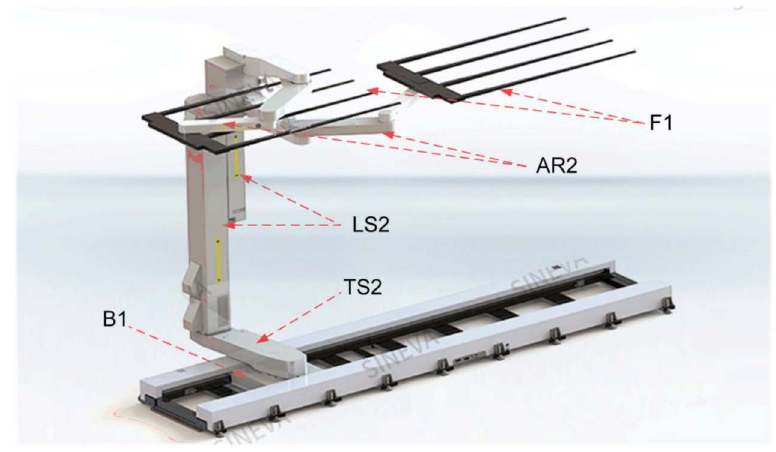
Figure 7. Optimal module configuration